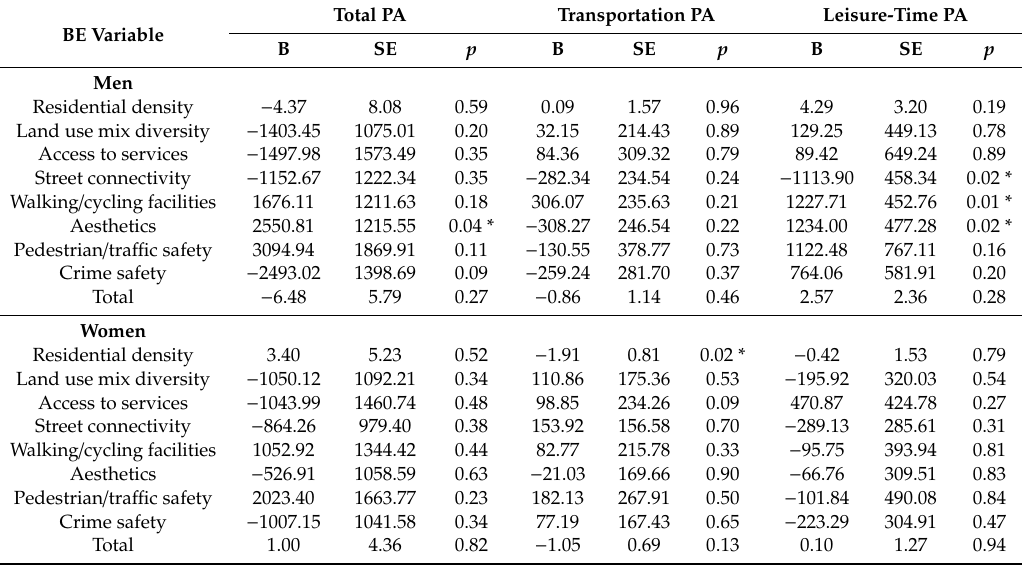
Table 3. Association a between BE and transportation PA, leisure-time PA. BE